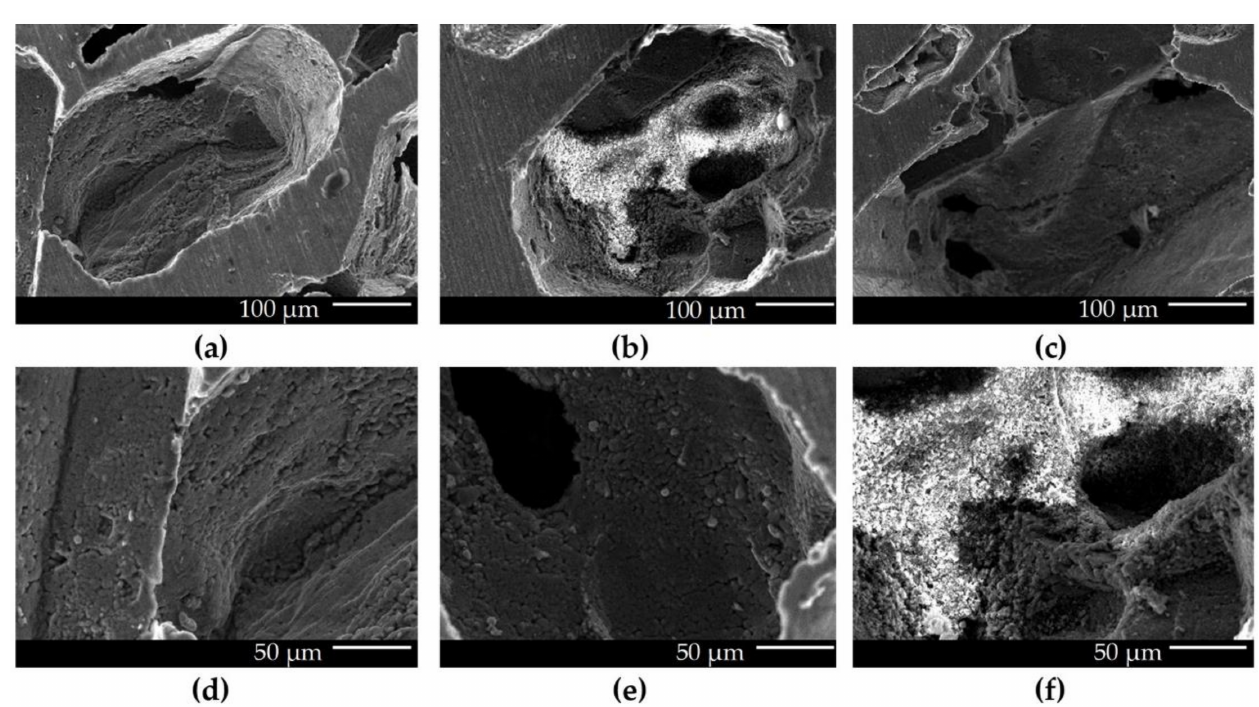
Figure 9. SEM micrographs of pore inner surfaces of the sintered Al foams with design porosities of ( a – d ) 50 vol.% ( b – e ) 60 vol.% and ( c – f ) 70